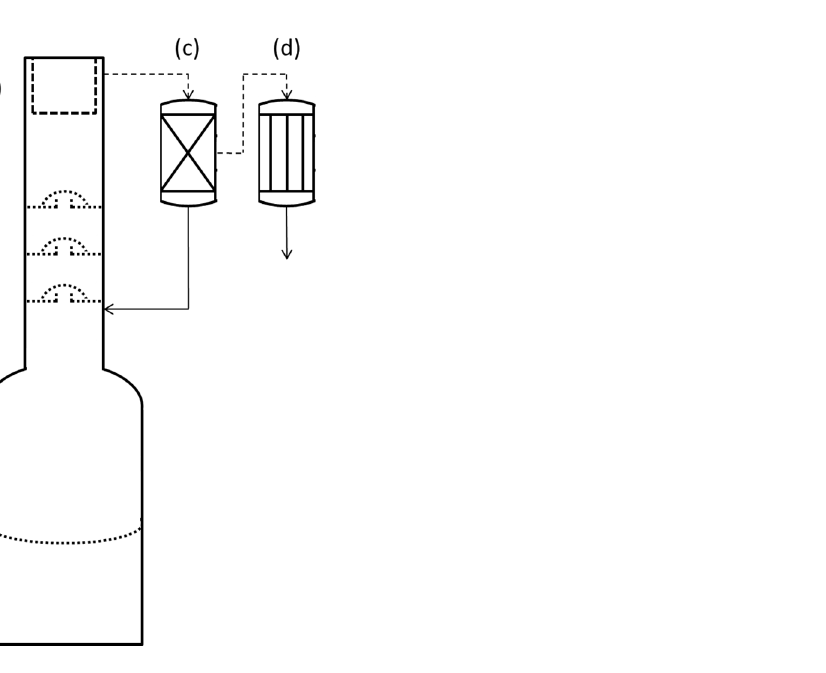
Figure 1. Schematic drawing of both column stills equipped with three trays ( a ), dephlegmator ( b ), copper catalyzer ( c ) and product cooler ( d ), thin dashed arrow line = vapor phase.